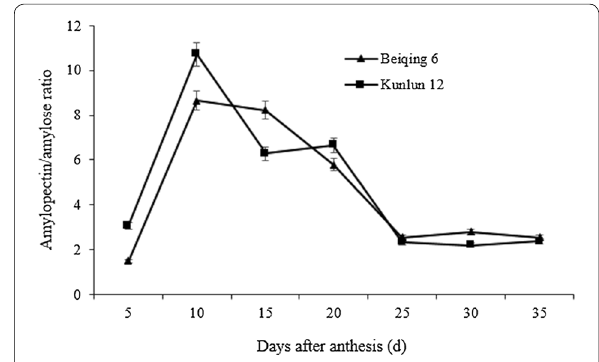
Fig. 3 The ratio of amylopectin and amylose in Beiqing 6 and Ganken 5. Error bars indicate standard deviation